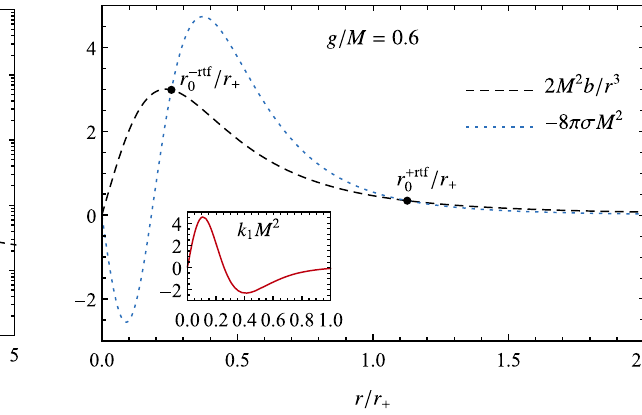
Fig. 5 Tidaltensorcomponent k 1 ,plottedintheinset,andtheseparated contributions to it, one from the anisotropy σ (blue dotted line, dirtiness term) and the other from the Misner–Sharp energy b ( r ) (black dashed